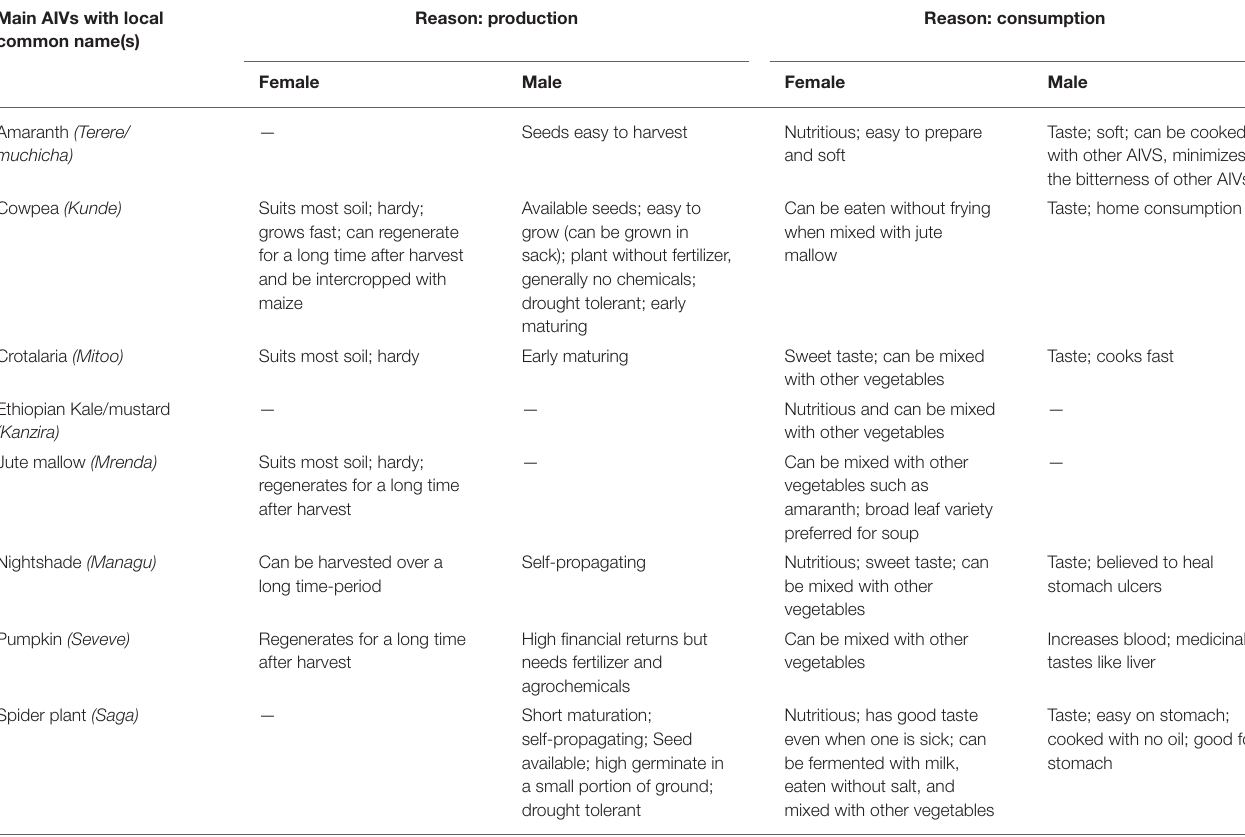
TABLE 2 | Top eight African Indigenous Vegetables reported by female and male focus groups and reasons for preferences relative to production and consumption. Main AIVs with local common